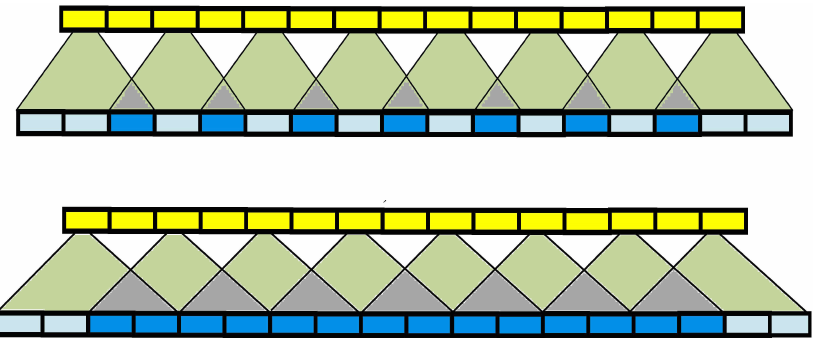
Figure 3. Upper Panel: A 1-D Deconv with uneven overlaps, where kernel size K = 3 and stride λ = 2. Bottom Panel: A 1-D Deconv with even overlaps, for K = 4 and stride λ = 2. The light blue units are the results of an upsampling operation, where dark blue units represent overlapped